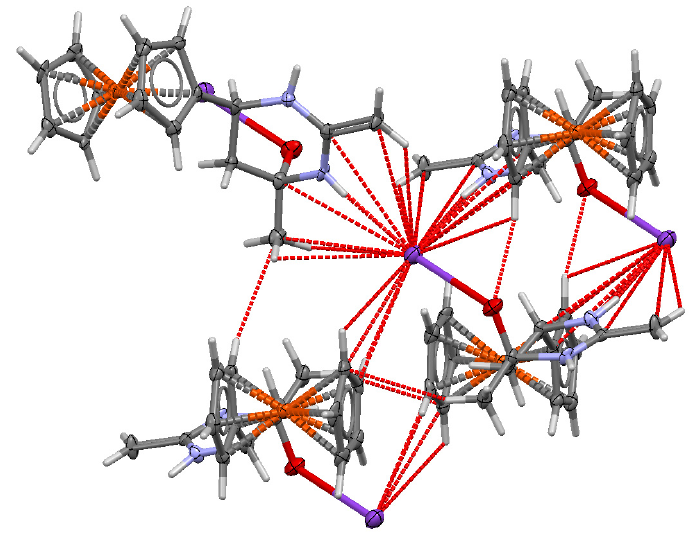
Figure 4. Fragment of X-ray crystal structure of 7